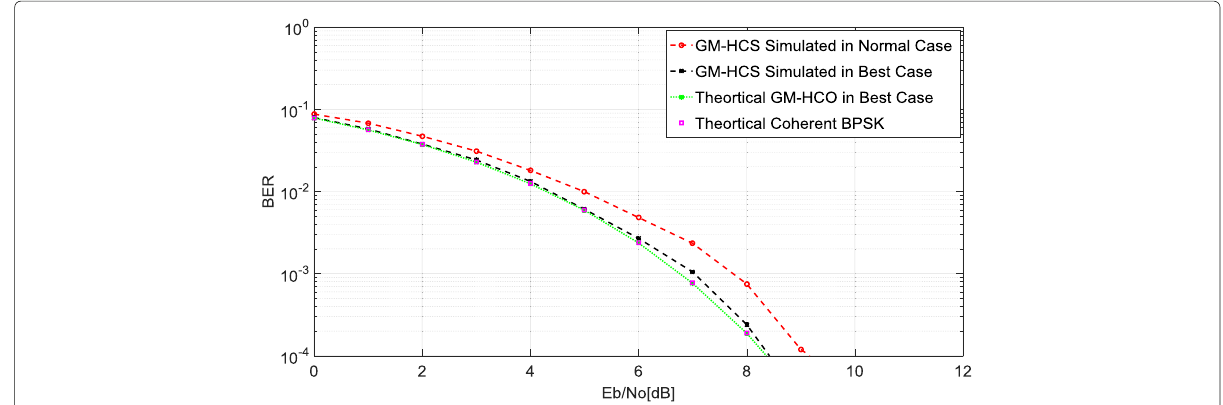
Fig. 6 The noise performance boundary of GM-HCO with data sequence of ±